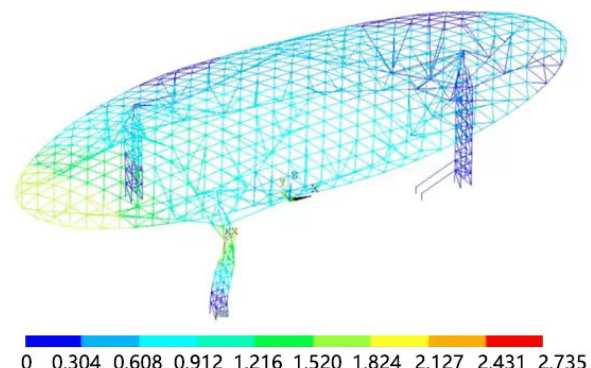
Figure 10. The load–displacement curve of the elastic buckling state.